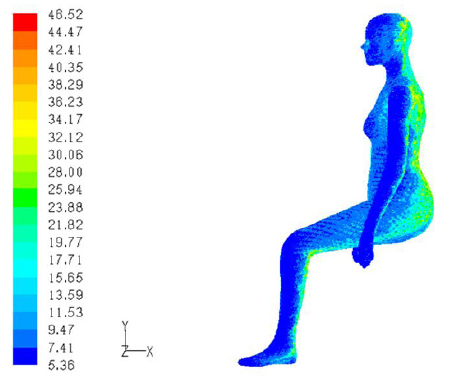
Figure 9. Latent heat flux density from the body surface [W/m 2 ].